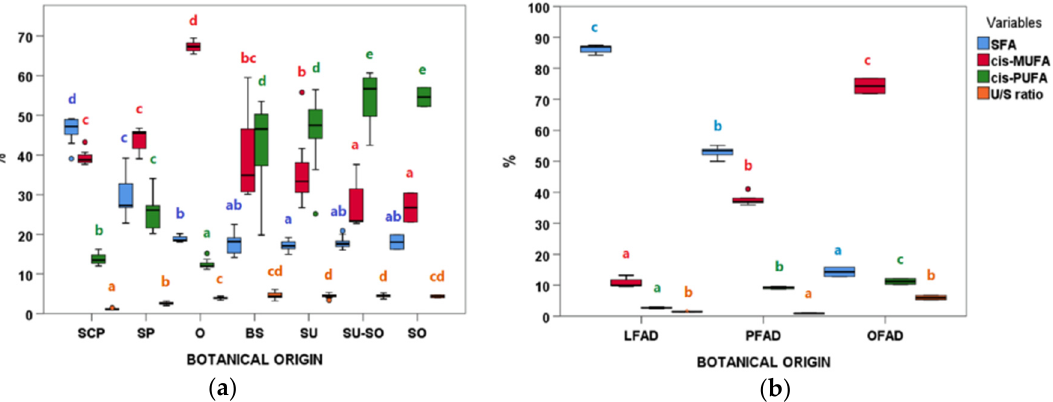
Figure 4. Saturated fatty acids (SFA), monounsaturated fatty acids (MUFA), polyunsaturated fatty acids (PUFA), and unsaturated/saturated ratio (U/S ratio) boxplots according to botanical groups for ( a ) acid oils from chemical refining ( n = 79). and ( b ) fatty acid distillates from physical refining ( n = 13) (see Table 1 for botanical group abbreviations). Within each type of refining and variable, botanical groups bearing different letters (a–e) are significantly different according to Kruskal–Wallis test and post-hoc comparisons ( p ≤ 0.05).